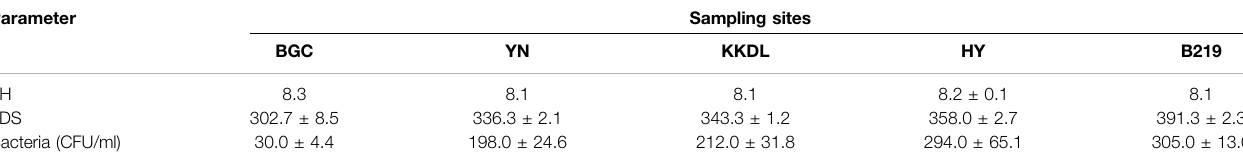
TABLE 1 | Physicochemical properties in the Ili River.